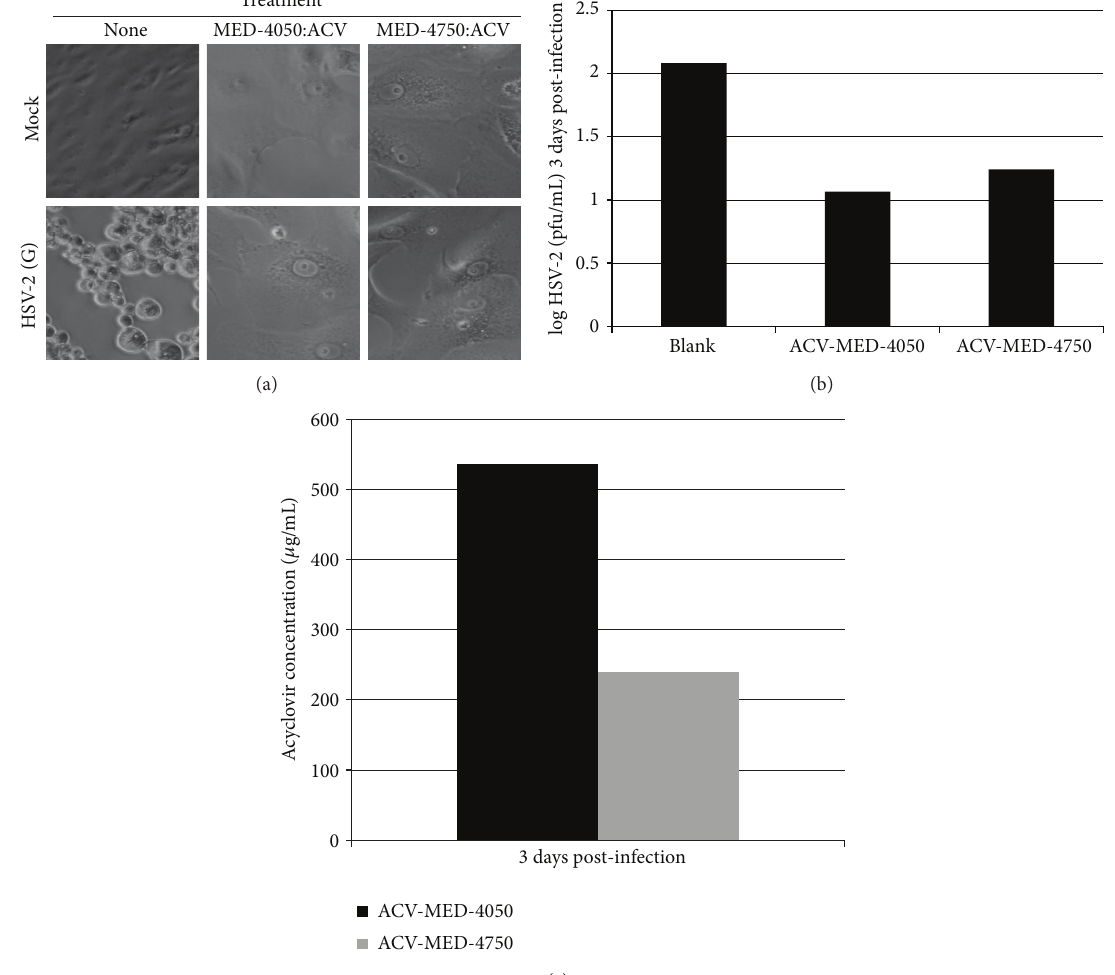
Figure 2: Comparison of in vitro antiviral activity of implants made from two different silicone polymers impregnated with ACV. Vero cells were grown to near-confluence in 24-well culture plates. One implant was placed in each well. Two days later, either medium alone (“Mock”) or HSV-2 (G) (95pfu) was added to the indicated wells. (a) Digital photographs were taken 3 days after infection. Wells in the first column (“None”) received neither implant nor ACV. The remaining wells received MED-4050 or MED-4750 impregnated with ACV, as indicated. Each implant was prepared by mixing polymer component A, polymer component B, and ACV in a 1: 1: 1 ratio as described in Section 2. Supernatants (200 𝜇 L) were removed from the culture 3 days after infection. (b) A portion of each captured supernatant (100 𝜇 L) was used to determine HSV-2 titer. (c) ACV was quantified from the other portion (100 𝜇 L) of the recovered